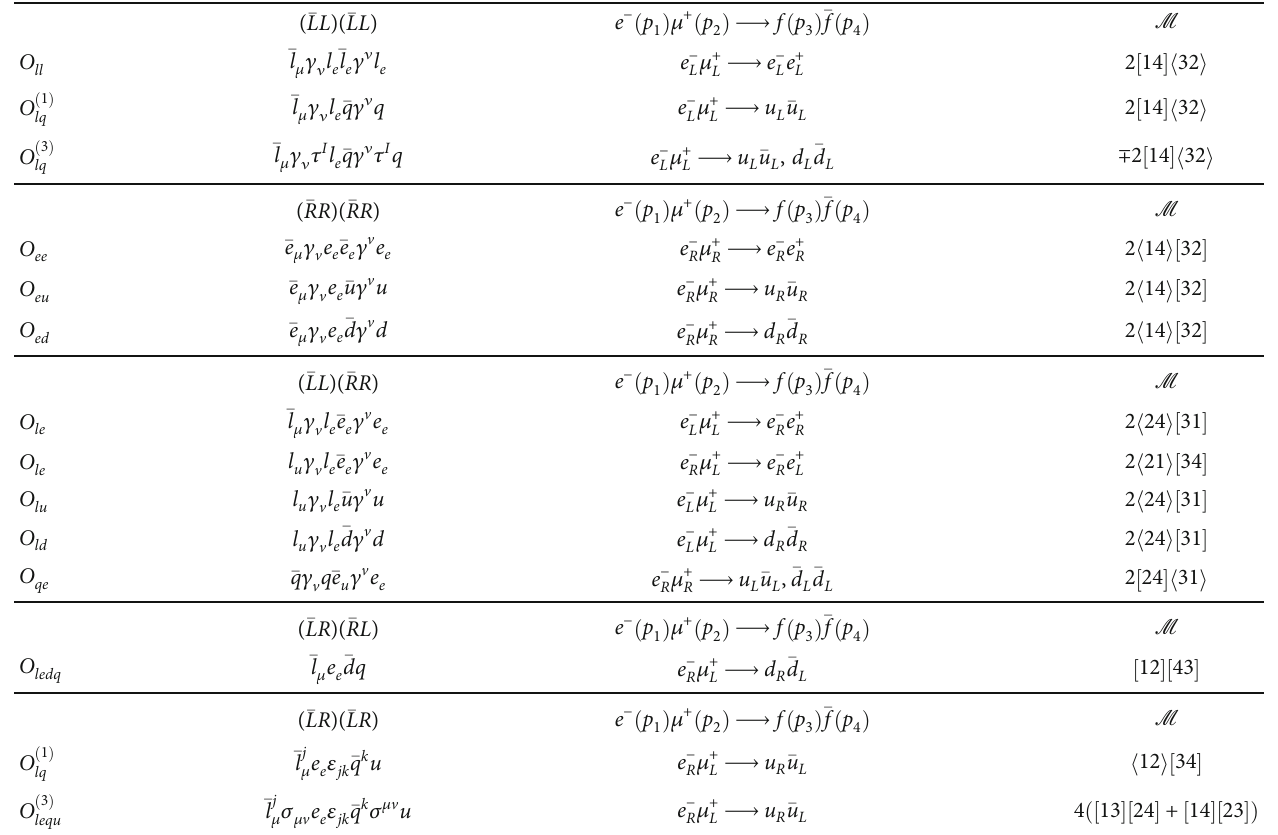
Table 1: Dimension 6 operators with common fl avor indices (2111) and the helicity amplitudes generated. The C The R , L indices refer to chiralities. Final state e − e + also stands for μ − μ + and τ − τ + . Similarly, d for c (cid:1) c . Top quarks excluded.